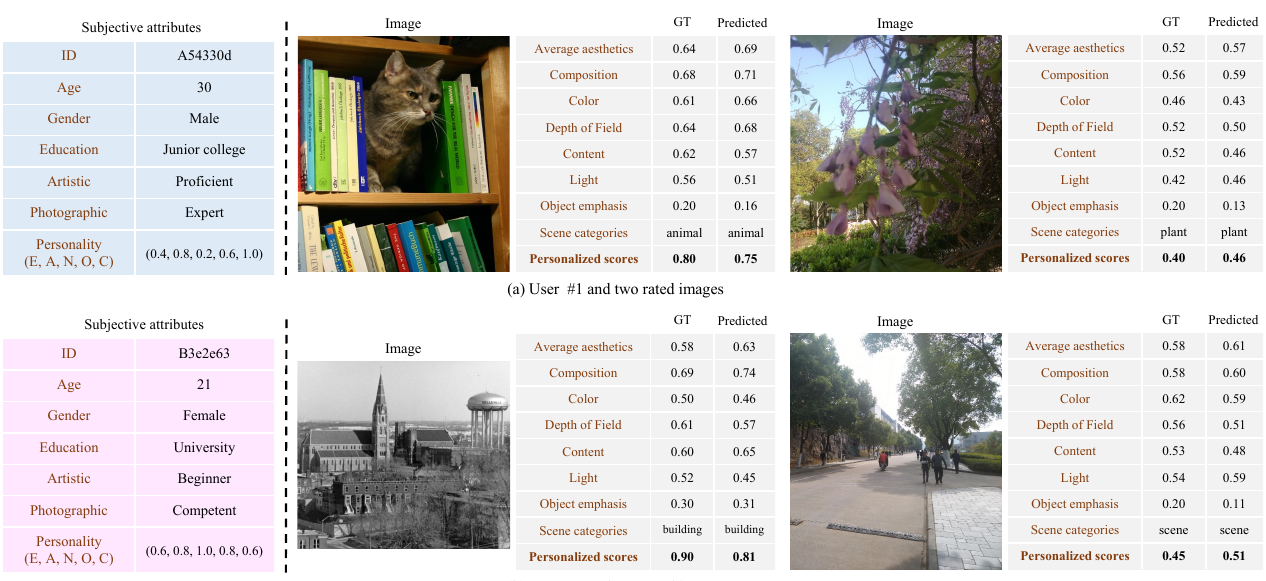
Figure 4. Qualitative results of the proposed model on two testing users from the PAPA database [10]. The identification (ID) information and some subjective attributes of these two users are shown on the left side. The average aesthetics of score distribution, objective attributes, and personalized scores of images are shown on the right side. For comparison, we show both the ground truth (GT) and predicted results, where aesthetic scores and numerical attributes are normalized to the range of 0 to 1 and higher values indicate stronger aesthetics and